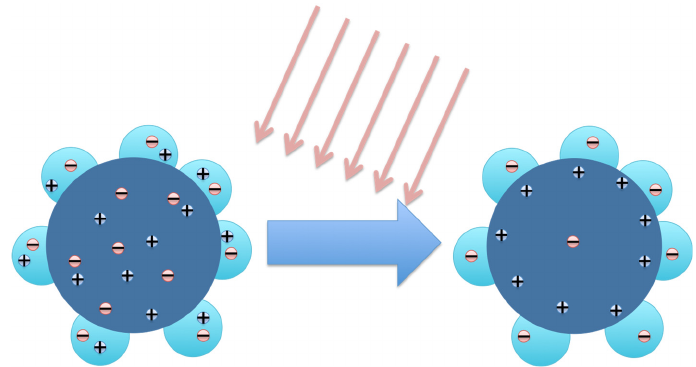
Figure 7. Sketch of carrier separation in the cross section of ZTO nanowires (NWs) decorated with ZnO quantum dots (QDs) upon illumination.